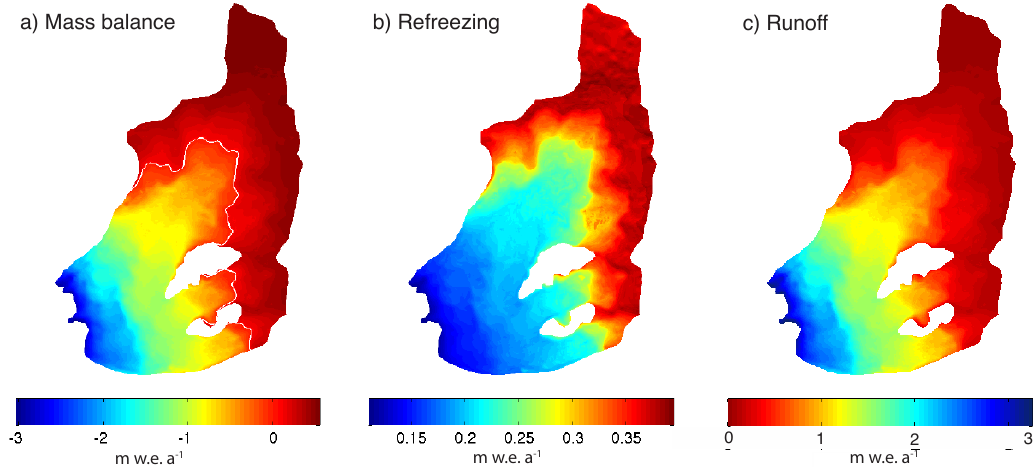
Fig. 4. Contour plots of the annual mean mass balance (a) , refreezing (b) and runoff (c) , averaged over the period 1989–2010. The white line in (a) marks the position of the equilibrium line.